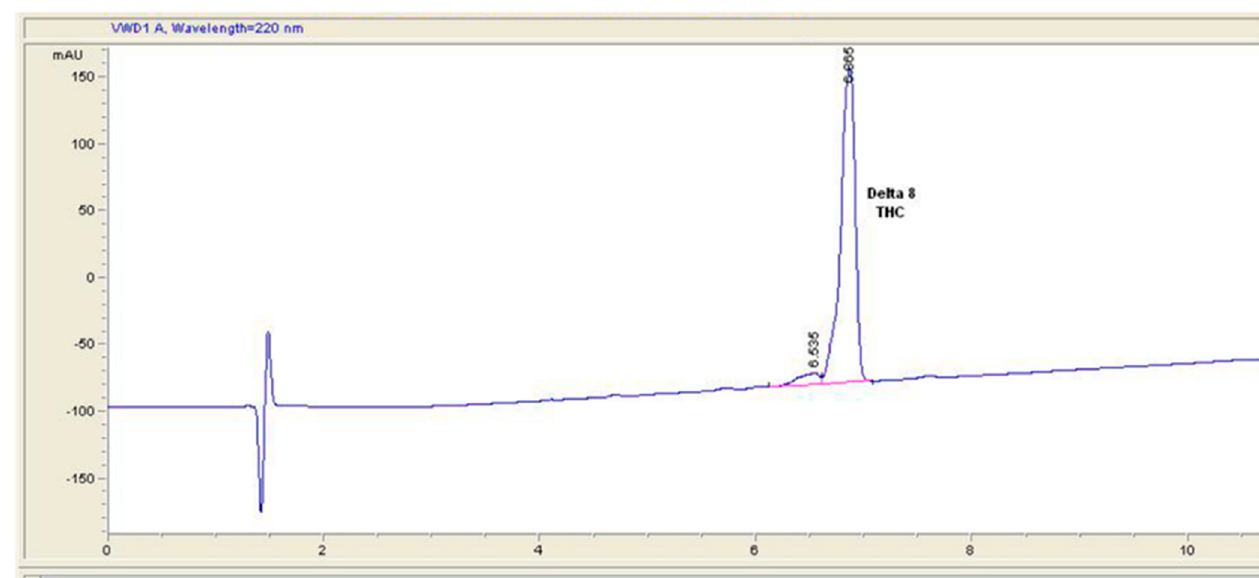
Figure 6. Certificate of Analysis chromatogram of sample 6.